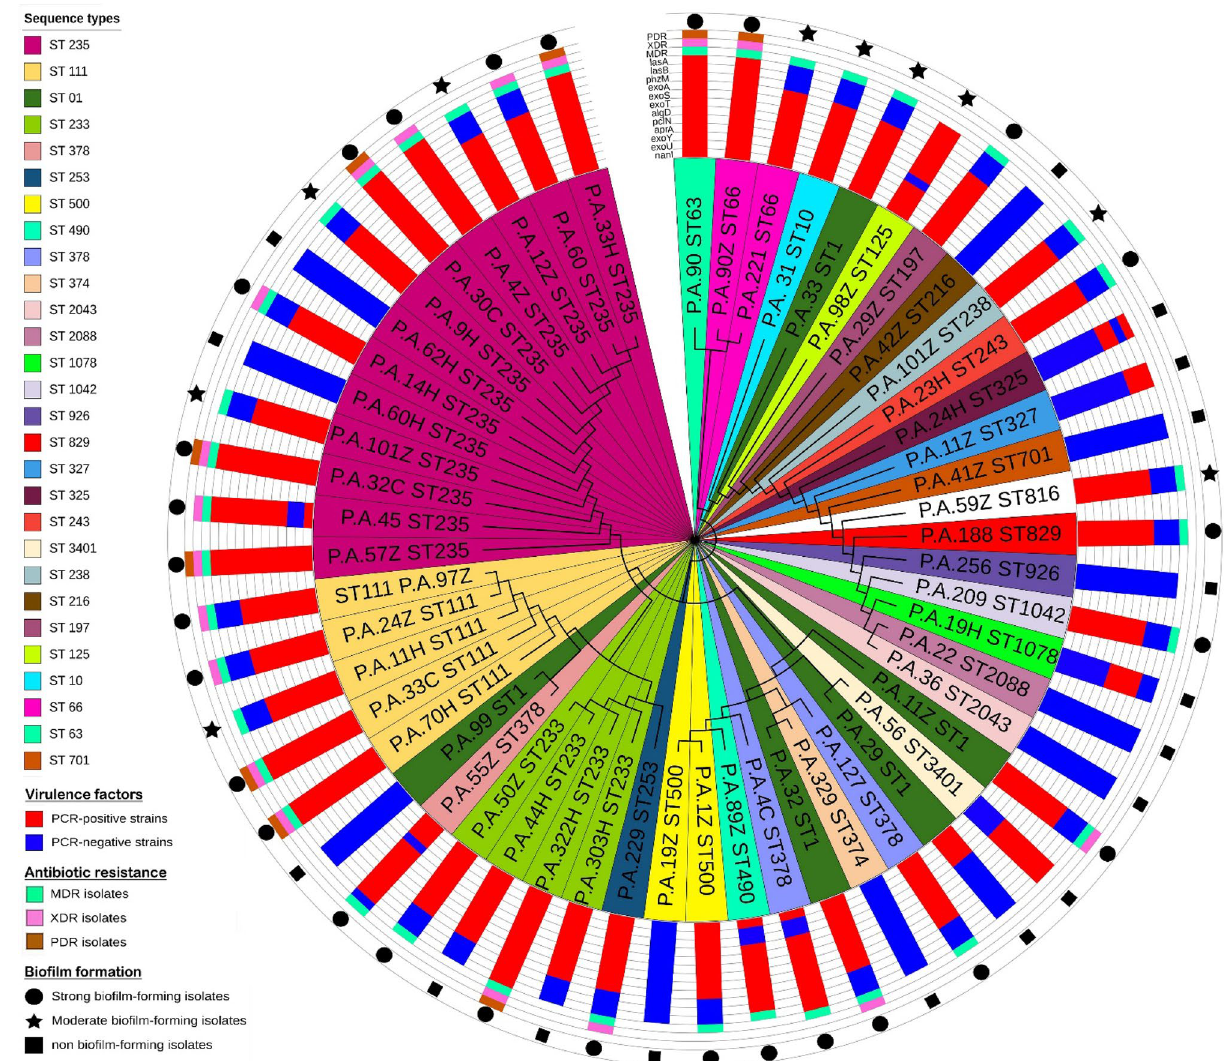
Figure 3. Neighbor-joining, unrooted, circular-dendrogram clustering of 55 isolates of P. aeruginosa isolates based on sequence type (ST) profiles. The STs in the same clonal complex are shaded in the same color. The circular-dendrogram was estimated by neighbor-joining using the k2 + G model, with MEGA 6, the tree- drawing tools PHYLIP and the iTOL online tool. Support values are calculated from 500 bootstrap replicates. The STs are shown in a different